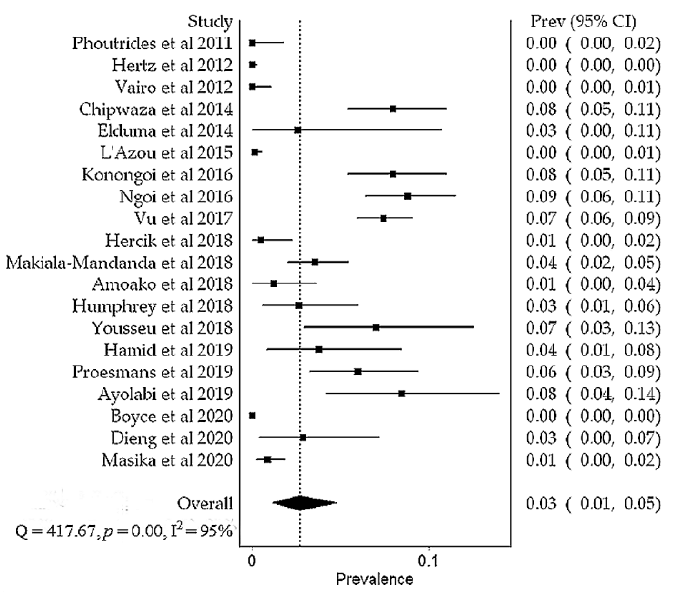
Figure 5. A meta-analysis of dengue virus prevalence in febrile patients during the non-outbreak periods.